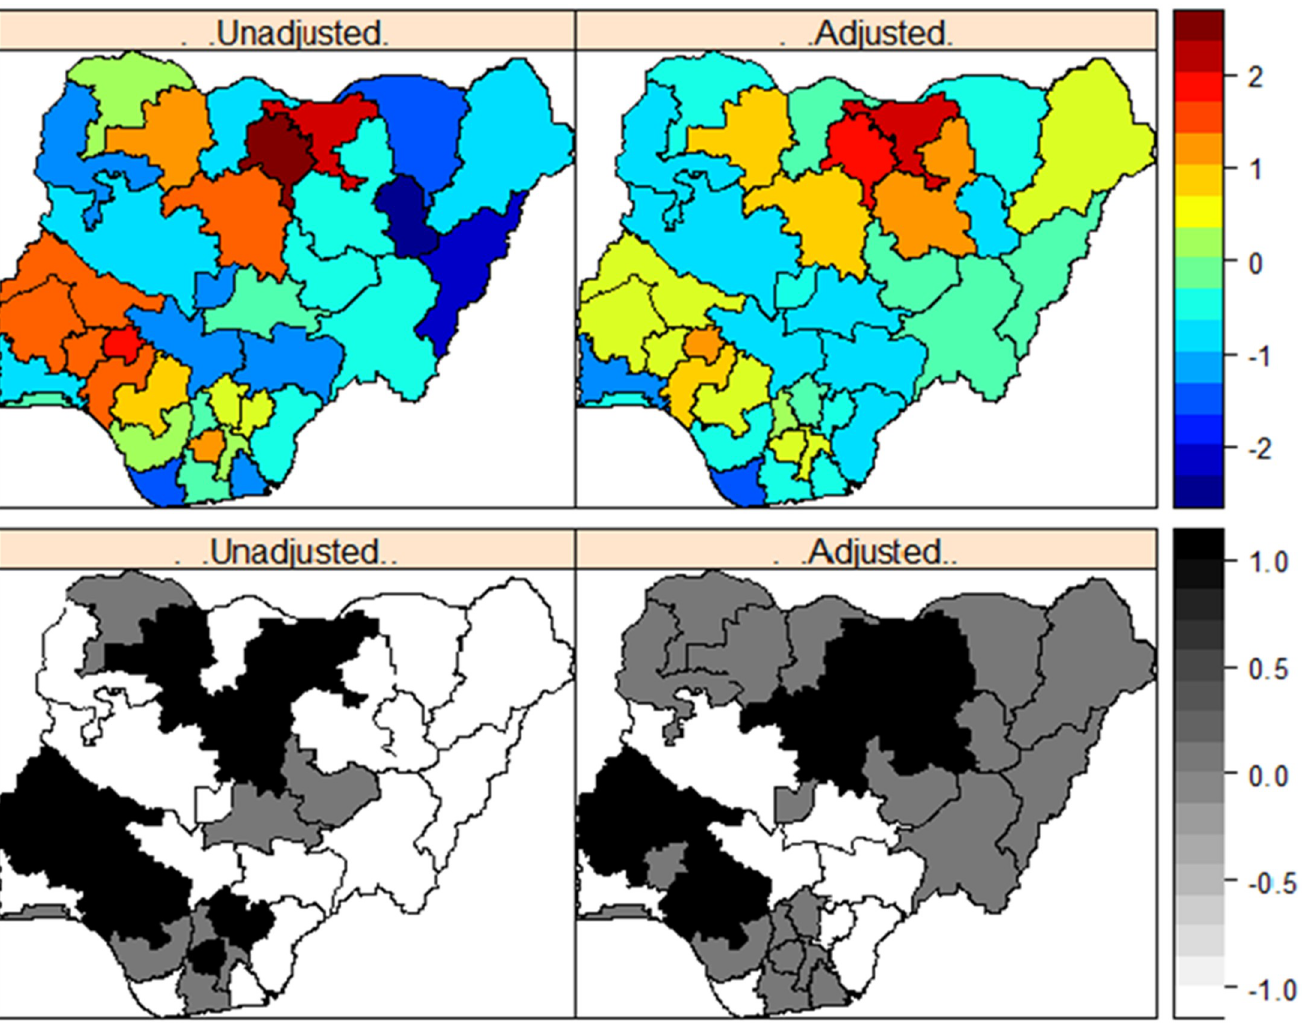
Fig 7. Posterior estimates of the effects of a girl’s likelihood of undergoing FGM/C in Nigeria based on the pooled 2003 to 2016 dataset. Mean (top panel). Significance maps of the posterior estimates based on 95% credible interval (bottom panel). Dark blue to dark red represent lowest to highest FGM/C risk states. Black, white and grey represent significantly high, low, and nonsignificant FGM/C risk states, respectively. Shapefile republished from DIVA-GIS database (https://www. diva-gis.org/) under a CC BY license, with permission from Global Administrative Areas (GADM), original copyright 2018.